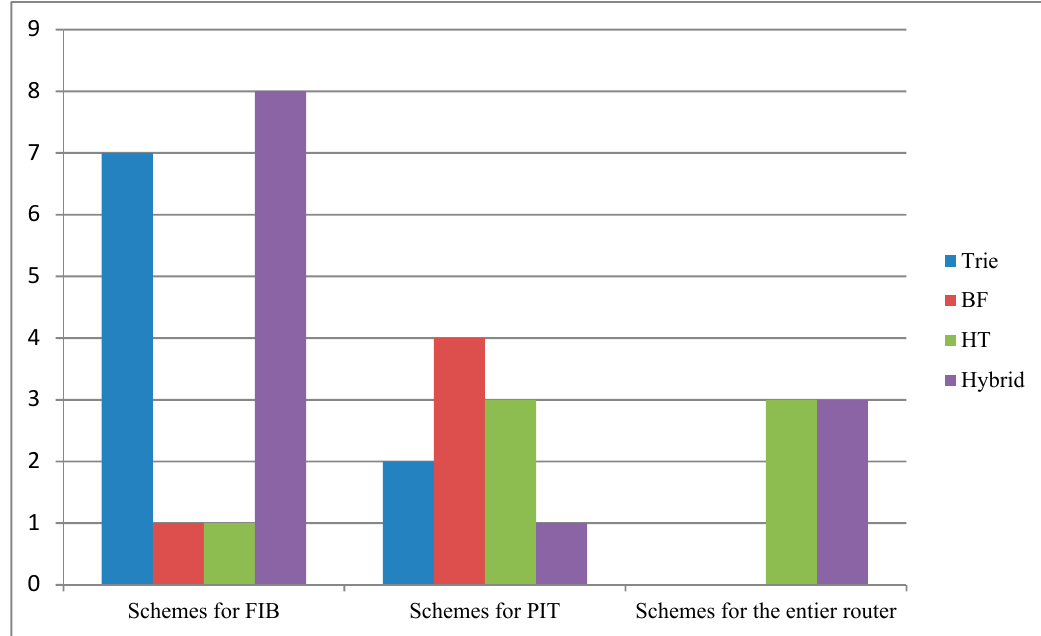
Figure7. Distribution of the paper schemes. Figure 7. Distribution of the paper